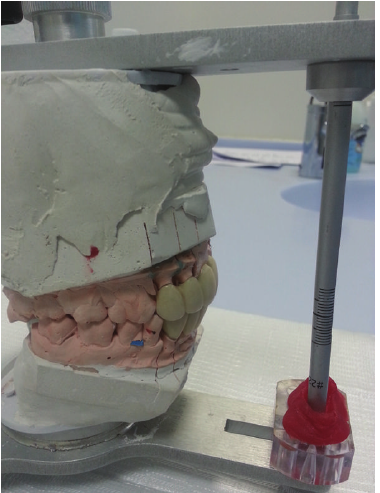
Figure 5: Customised incisal table.